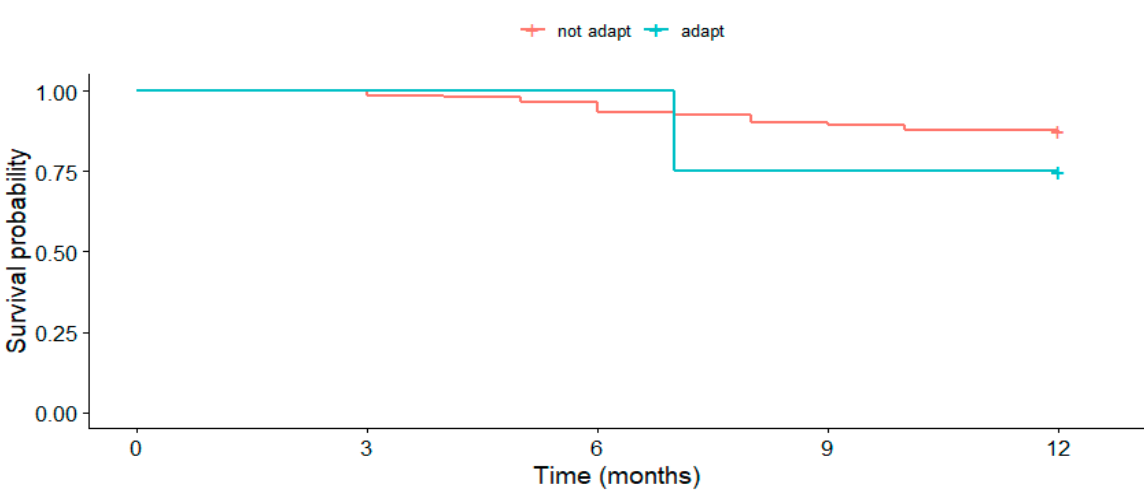
16 of 22 Figure 1. Business sector (S1).